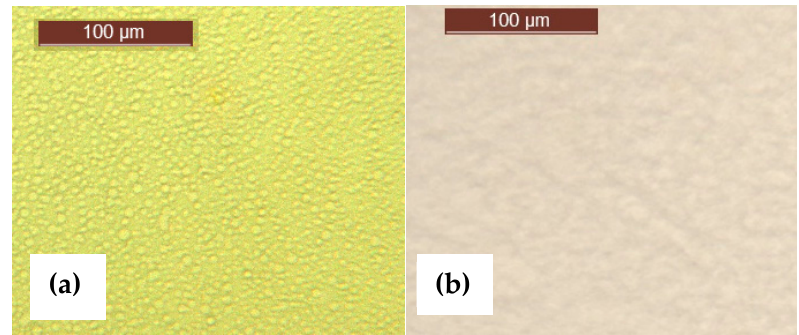
Figure 2. Morphology of uncured ( a ) ELP800 and ( b ) ELP25000 mixtures.